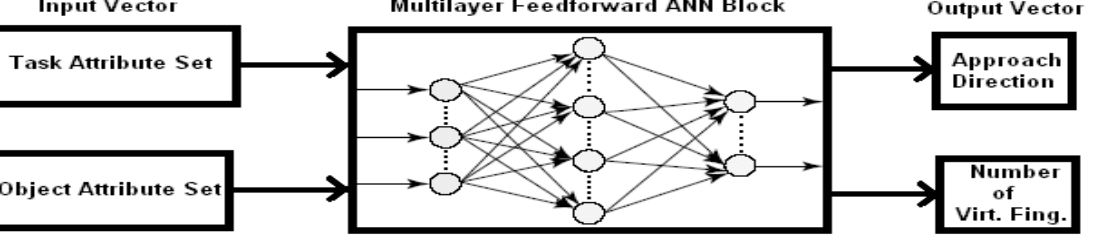
Figure 5. Structure of ANN for Hand Approach Plane Estimation.